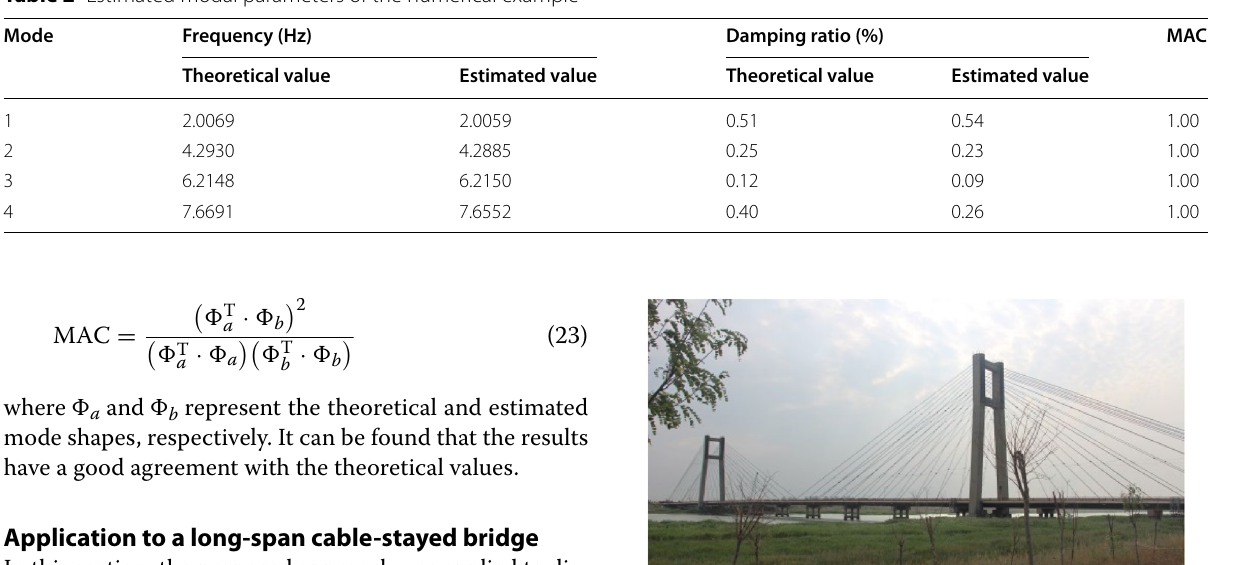
Table 2 Estimated modal parameters of the numerical example